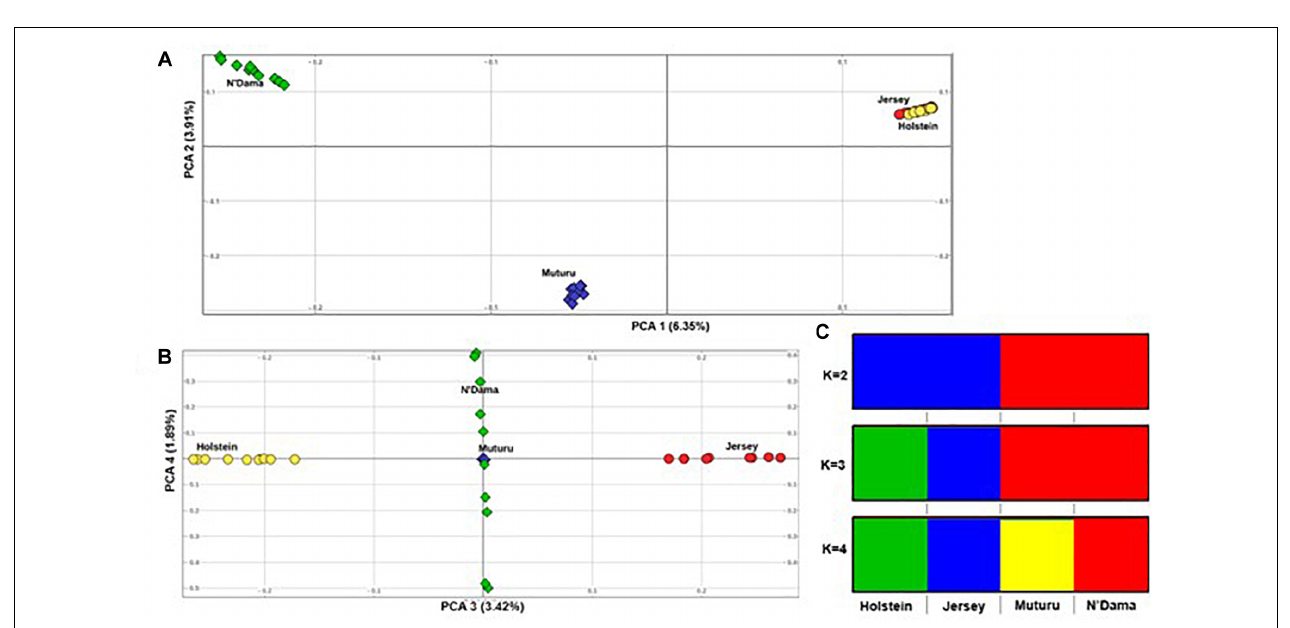
FIGURE 2 | Heat map of genetic relationships among the four B. taurus based on average Nei’s genetic distances matrix. (A) individuals and (B) populations comparisons. MUT, Muturu; NDM, N’Dama; HOL, Holstein; JER, Jersey.